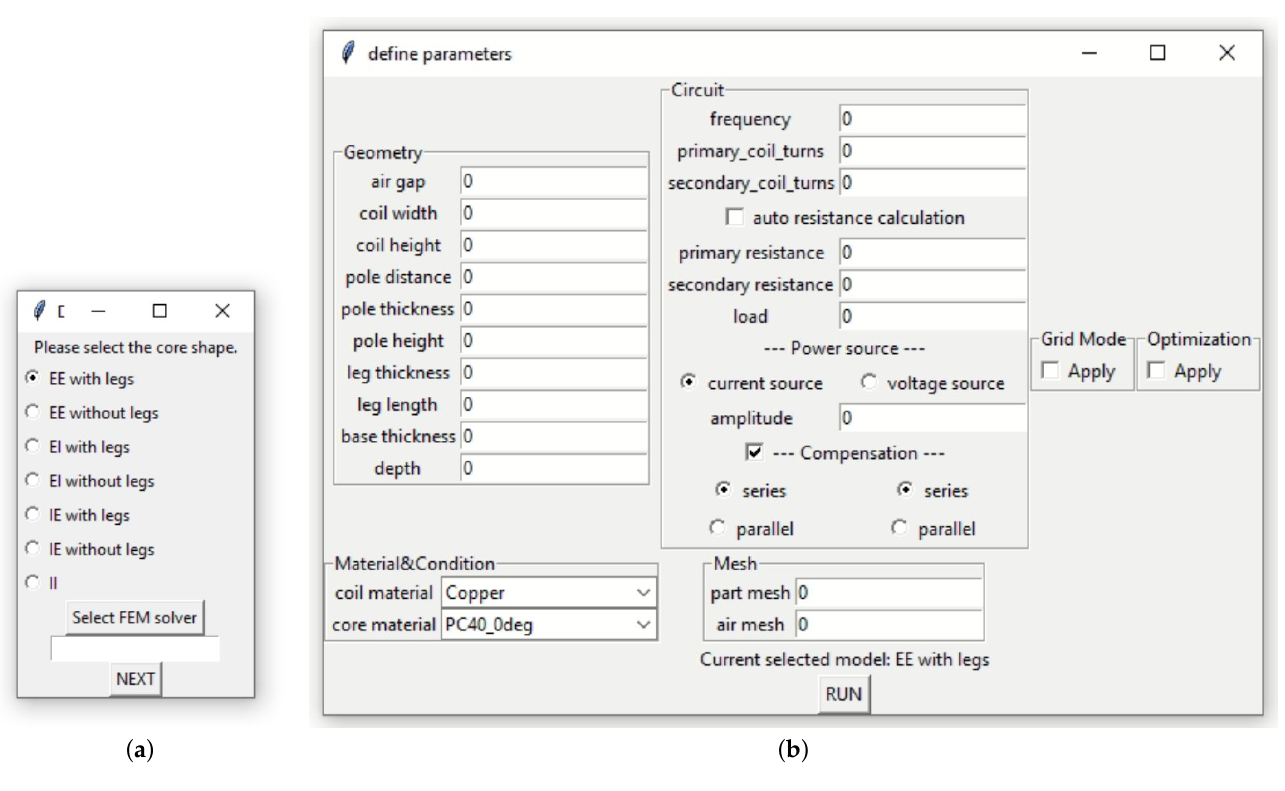
Figure 4. The interface of the proposed software. ( a ) is the core shape and FEM analyzer selection window and ( b ) is the detailed parameter customization window when EE shape with legs is